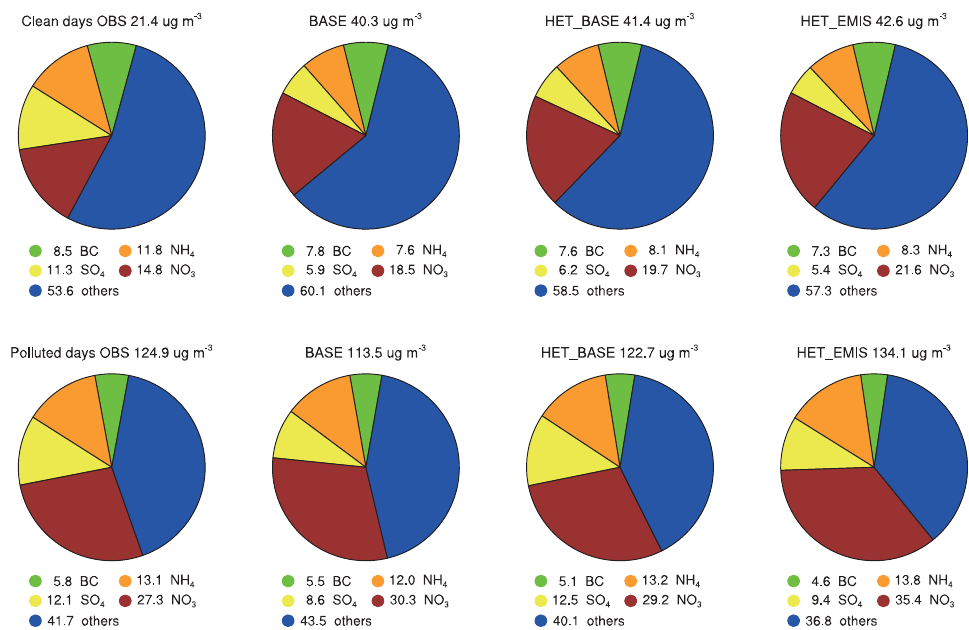
Figure 7. Pie charts of observed and simulated mass fractions of PM 1 species on relatively clean days (observed PM 2 . 5 <75µg m − 3 ) and polluted days (observed PM 2 . 5 ≥ 75µgm − 3 ) between 15 and 31 October. The units of total PM 1 concentrations (listed in panel titles) are µgm − 3 . The species fractions (listed in panel labels) are in percentage (%).